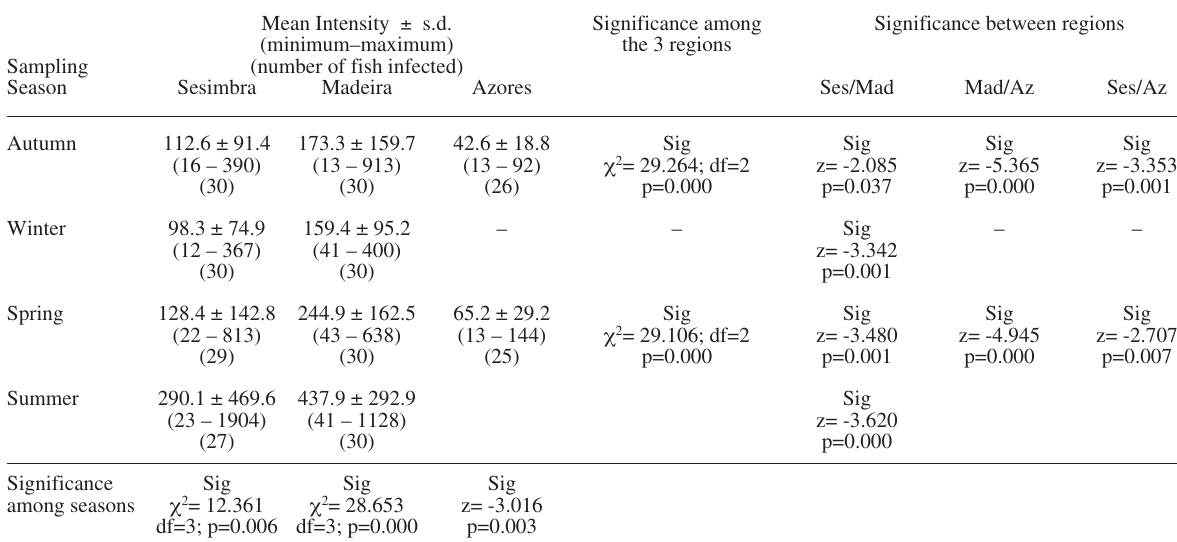
Table 4. – intensity of Anisakis larvae infection in Aphanopus carbo according to the season of the year: significance of intensity differences among seasons and regions estimated by the kruskal-Wallis ( c 2 ; df; p) or Mann-Whitney (z; p) test (sig, significantly different). Mean intensity ±